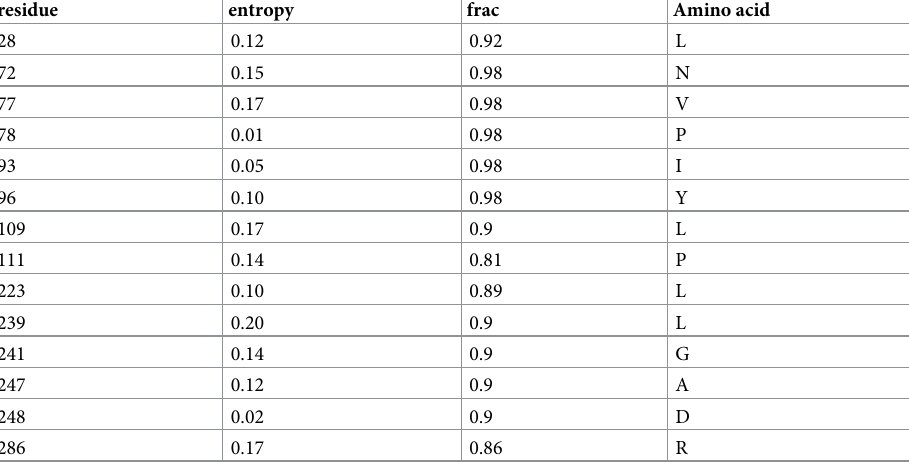
affect GDAP1 function; indeed, Trp238 and Arg282 are CMT mutation sites. These 3 residues cluster on the side of GDAP1, which must face the MOM surface. One option is that the bound fatty acid, in fact, mimics the membrane surface, and that these residues are directly involved in membrane surface binding at the outer surface of the MOM. Table 5 shows the entropy calculated for a combined data set (GDAP1, GDAP1L1, and GST). Since the GST superfamily is so diverse, we identified sites with entropy < 0.2 (less con- served than the calculation within a family). The 14 sites that are conserved and present in at least 70% of the sequences are listed in Table 5 . These include Leu239 and Gly241 in the α 6- α 7 loop and Ala247 and Asp 248 on helix α 7. The effect of the A247V mutation on protein stabil- ity may have been therefore expected based on its conservation across this very broad set of GSTs. Table 5. Entropy analysis for the large data set including the GST dataset. Shown are residue positions with the lowest entropy (S <